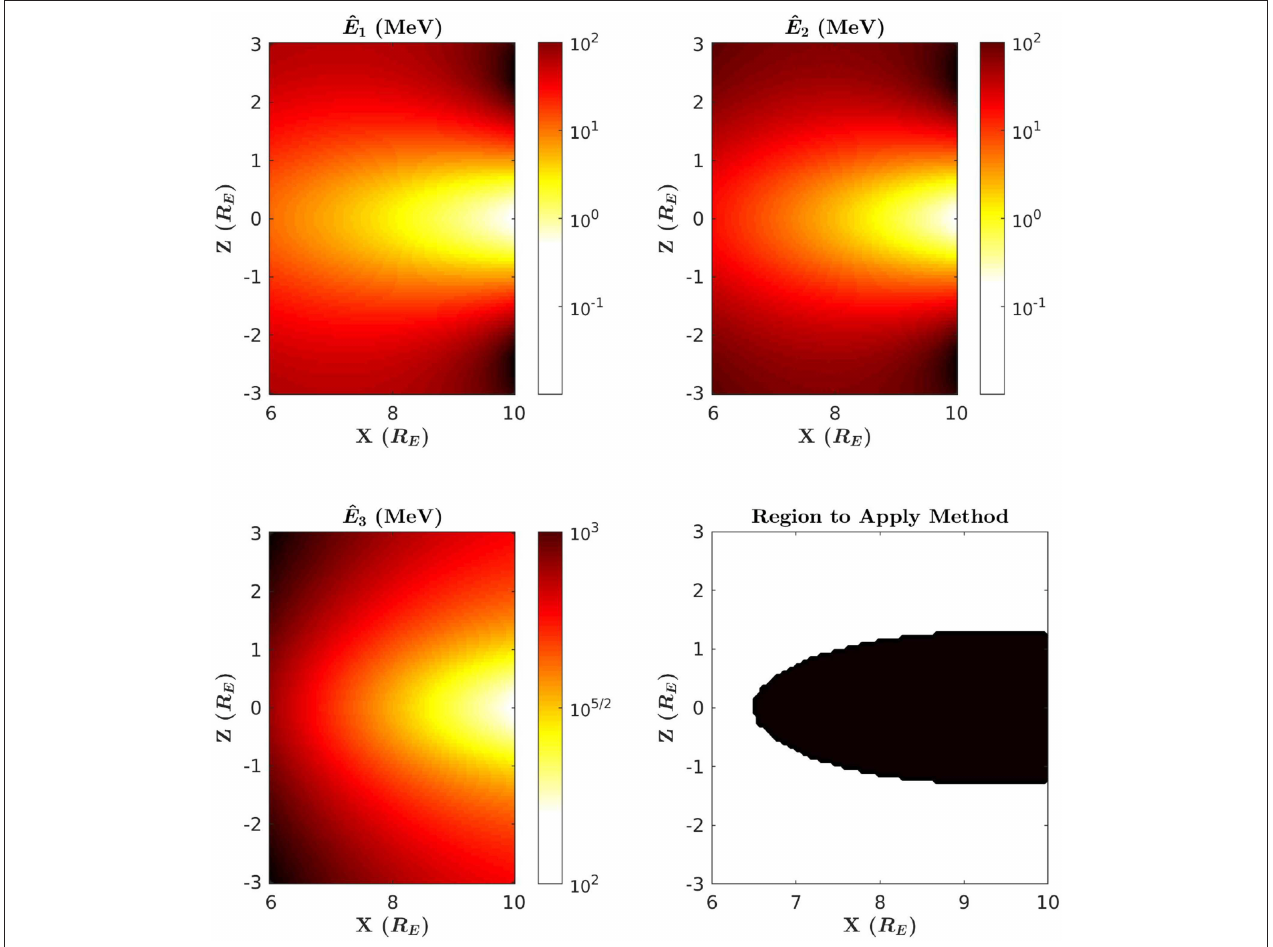
FIGURE 2 | ˆ E 1 , ˆ E 2 , and ˆ E 3 computed over midnight local time in the case of K p = 1. Bright colors indicate lower energy, and darker colors indicate higher energy. ˆ E 1 is shown in the top left panel, ˆ E 2 in the top right, and ˆ E 3 in the bottom left. In the bottom right panel, the region where this method should be applied is shown in